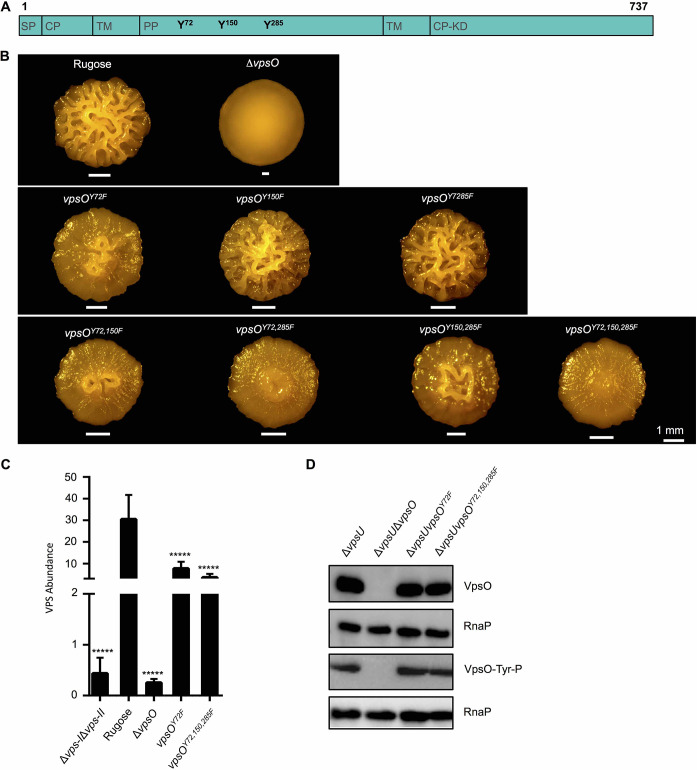
Phosphorylation of the periplasmic tyrosine residues impact VPS production without altering VpsO tyrosine phosphorylation.(A) Diagram of the VpsO protein highlighting the positions of the potential periplasmic domain phosphorylation sites. (B) Colony corrugation phenotypes of the periplasmic domain mutants after 5 days of growth at 25°C. (C) Quantification of VPS production by the periplasmic mutants compared to the rugose strain; n = 2 for biological replicates each with n = 3 for technical replicates. *****, p < 0.0005 by one-way Anova multiple comparisons test. The Δvps-IΔvps-II, rugose, ΔvpsU, and ΔvpsO control are identical to Fig 5C. (D) Western blot analysis of VpsO abundance and tyrosine phosphorylation; n≥3.